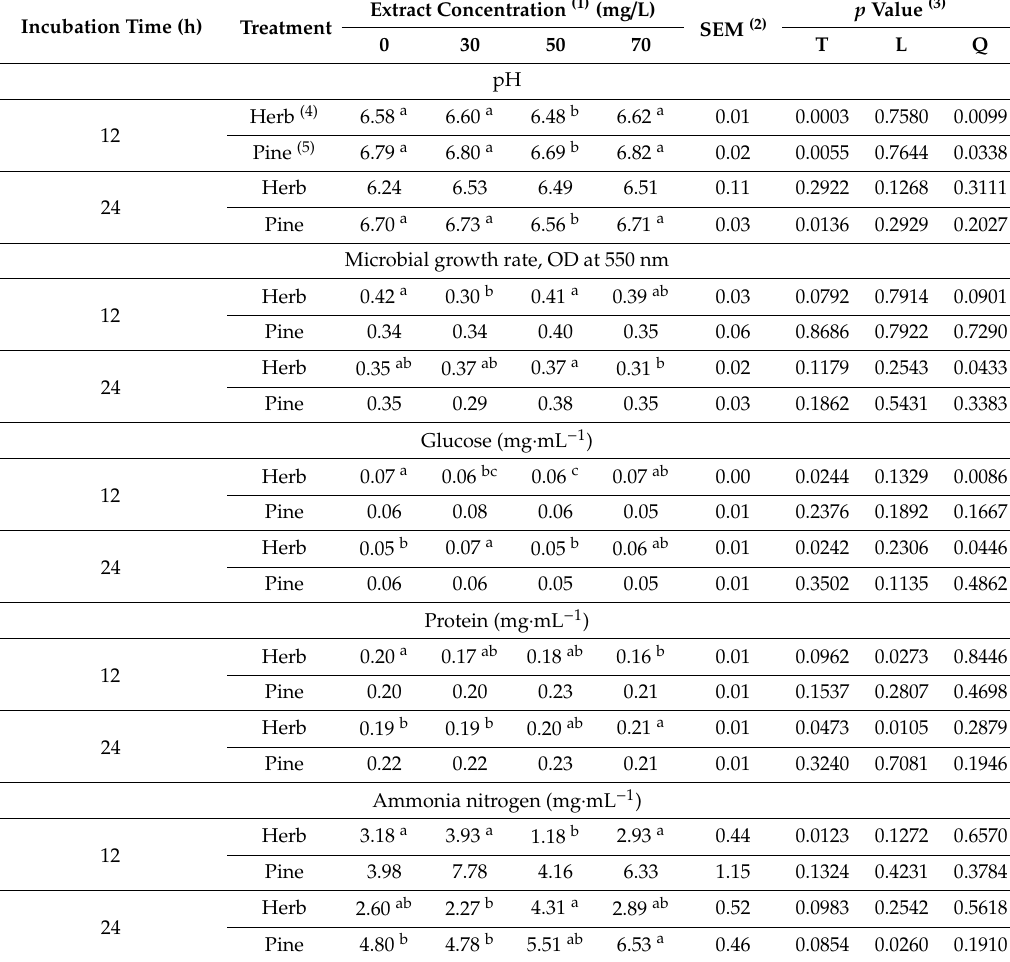
Table 2. E ff ects of terpene-based plant extracts on ruminal fermentation characteristics after 12 and 24 h of in vitro